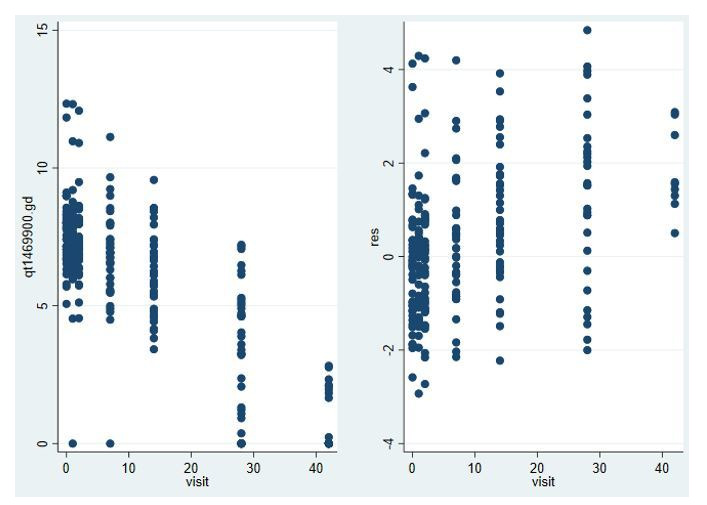
Model fit for male gametocytes in trial in Malian gametocyte carriers treated with non-gametocytocidal drugs dihydroartemisinin-piperaquine or amodiaquine plus sulfadoxine-pyrimethamine (NCT02831023).Log male gametocyte densities at different days of follow-up (left) and residuals of non-zero male log gametocyte densities as a function of time of follow-up (right).